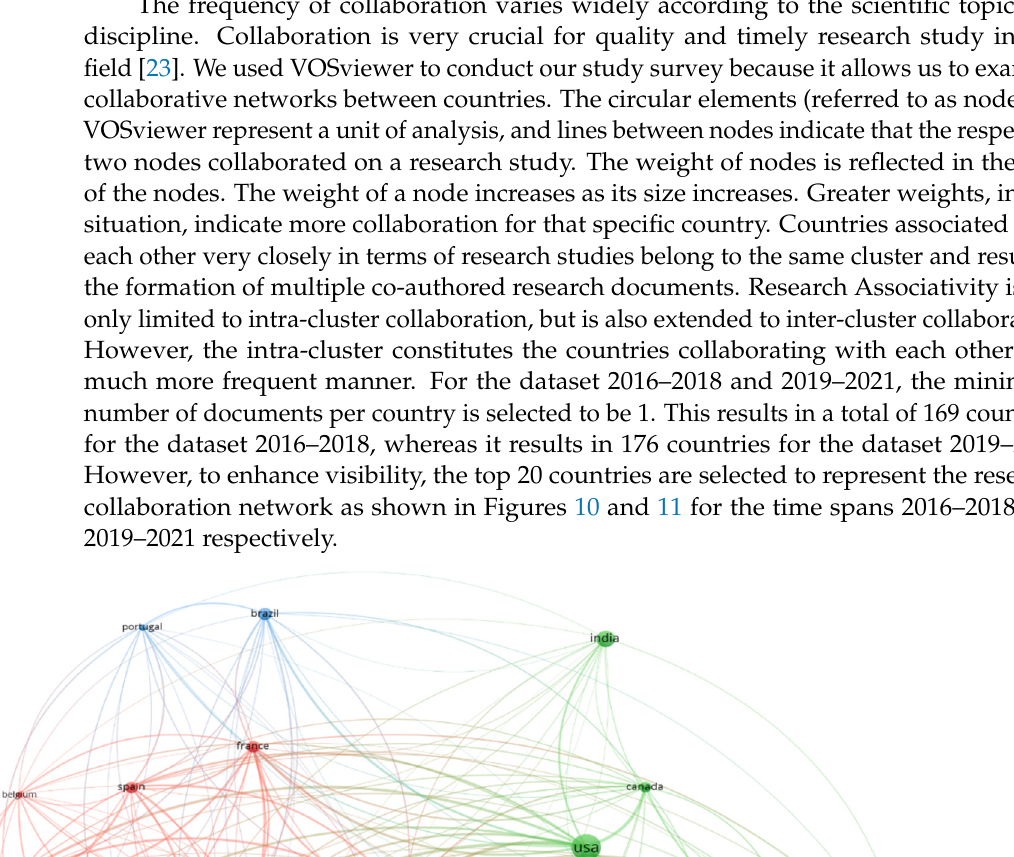
Figure 11. Research collaboration network amongst top 20 countries in terms co-authored docu- ments (2019–2021). The results also state that collaboration plays a vital role in enhancing countries’ re- search outputs. Two of the most prominent countries from publications have the largest collaboration networks. These collaborations pave way for conducting timely research. Countries belonging to one cluster tend to collaborate more frequently than those belong- ing to other clusters 4.11. Correlation of Documents on the Basis of Co-Words Co-word analysis is the method that is used to see the pattern of co-occurrence of keywords in a dataset [35]. Co-word analysis signifies the connections between the articles